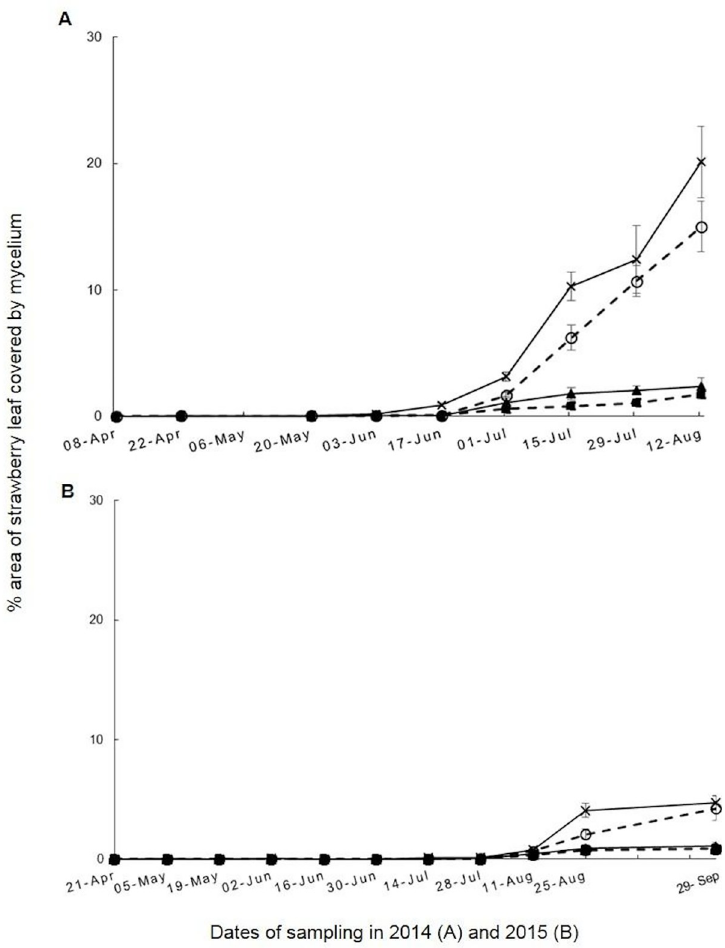
Fig 1. Percentage strawberry leaf area covered by Podosphaera aphanis mycelium plotted against time in 2014– 2015 experiments. Treatments in (A) Blackberry Field in 2014 (08 April-12 August) and in (B) Pheasant Field in 2015 (21 April-29 September) were: untreated control , commercial fungicide only , 0.017% silicon nutrient (by volume) alone applied once a week without commercial fungicide) , 0.017% silicon nutrient (by volume) applied once a week, plus commercial fungicide . Vertical axis indicates mean % area of strawberry leaf covered by mycelium (75 leaves per treatment). Horizontal axis shows dates of sampling with a total of 9 (in 2014) and 11 (in 2015) samplings during the experimental period. AUDPC and infection rate r values were calculated. Error bars represent standard errors of means of five